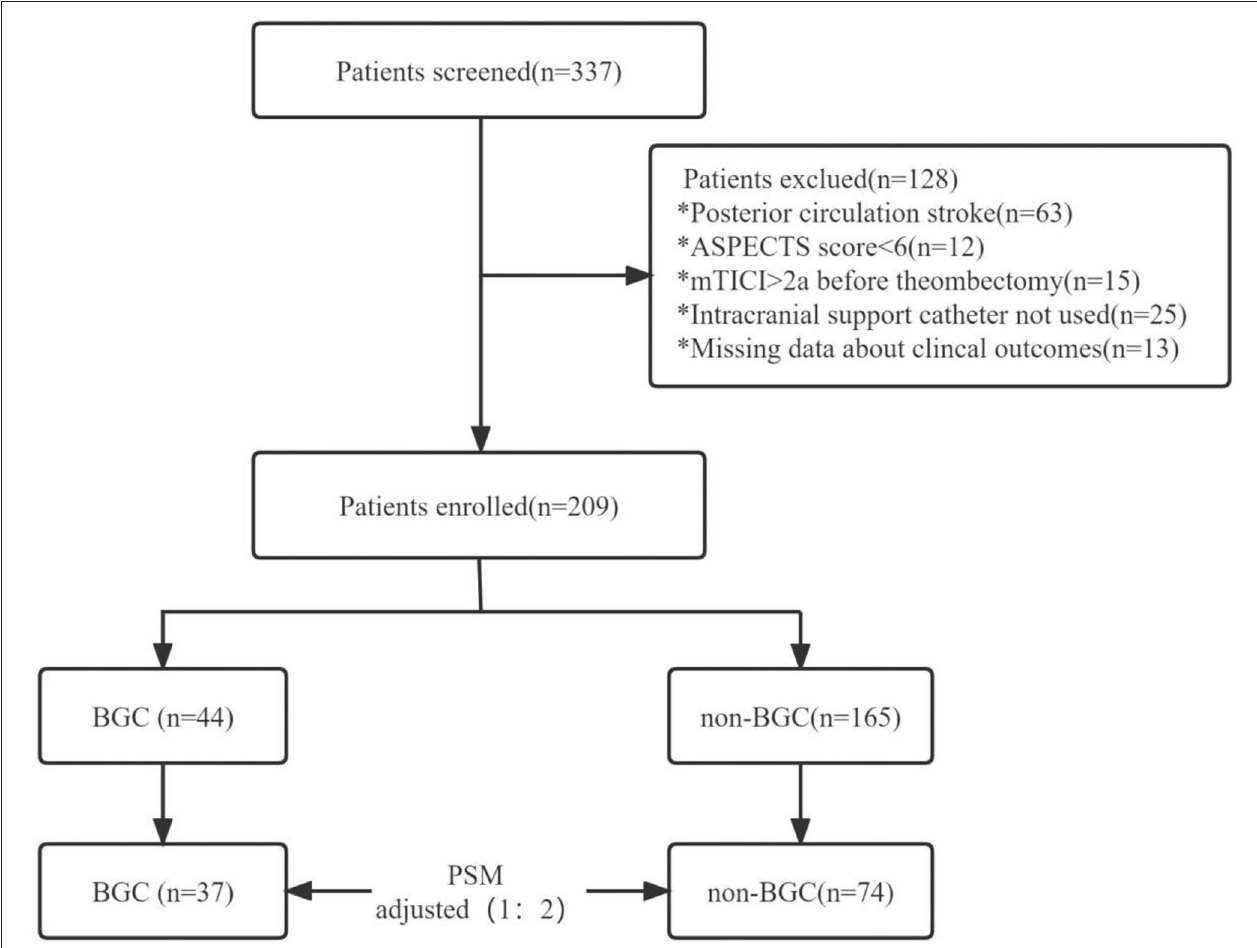
FIGURE 1 | Study flow chart. ASPECTS, Alberta stroke program early CT score; mTICI, modified thrombolysis in cerebral infarction; BGC, balloon-guided catheter; PSM, propensity score matching. *Playing the role of classification and identification.